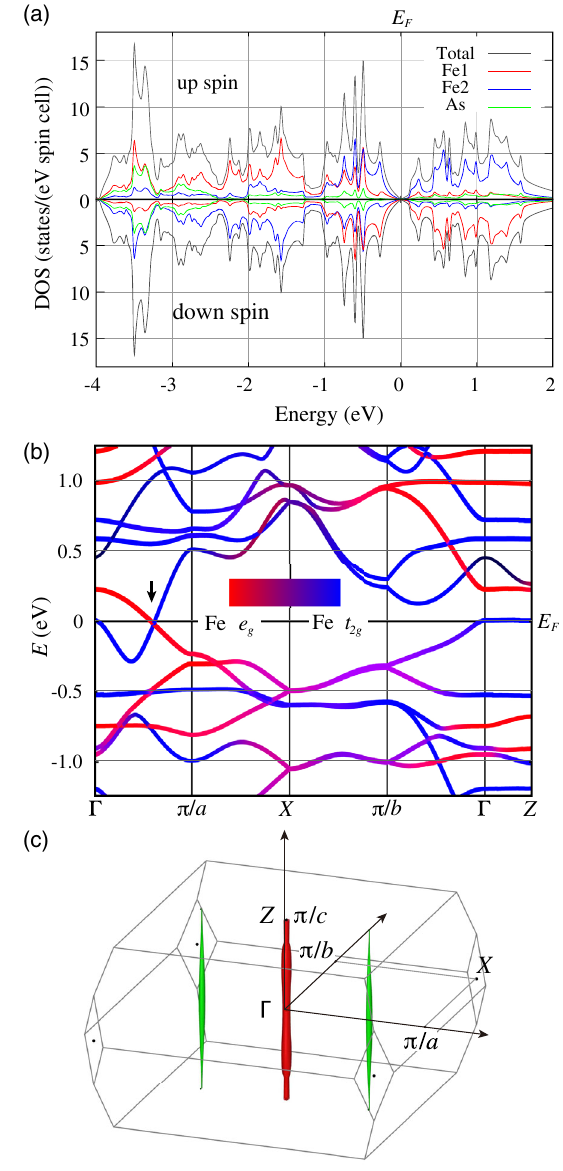
FIG. 7. Results of the band-structure calculations with spin- orbit coupling. (a) The total and partial densities of states. Up spin is shown above the axis, and down spin below. Fe1 and Fe2 refer to iron sites belonging to different magnetic sublattices (see Fig. 1). (b) Band structure near the Fermi level. The vertical arrow indicates the Dirac point. The color coding is based on orbital weights as explained by the inset, where e refers to g þ d þ d þ d d d , while t 2 . (c) Fermi surface in g XZ YZ XY Z 2 X 2 − Y 2 the antiferromagnetic Brillouin error in the α frequency, and/or off-stoichiometry. See Table I for other parameters such as Fermi velocity and energy.